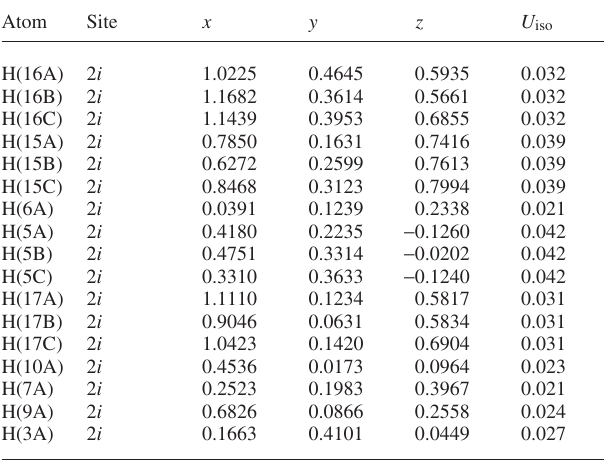
Table 2. Atomic coordinates and displacement parameters (in Å 2 )